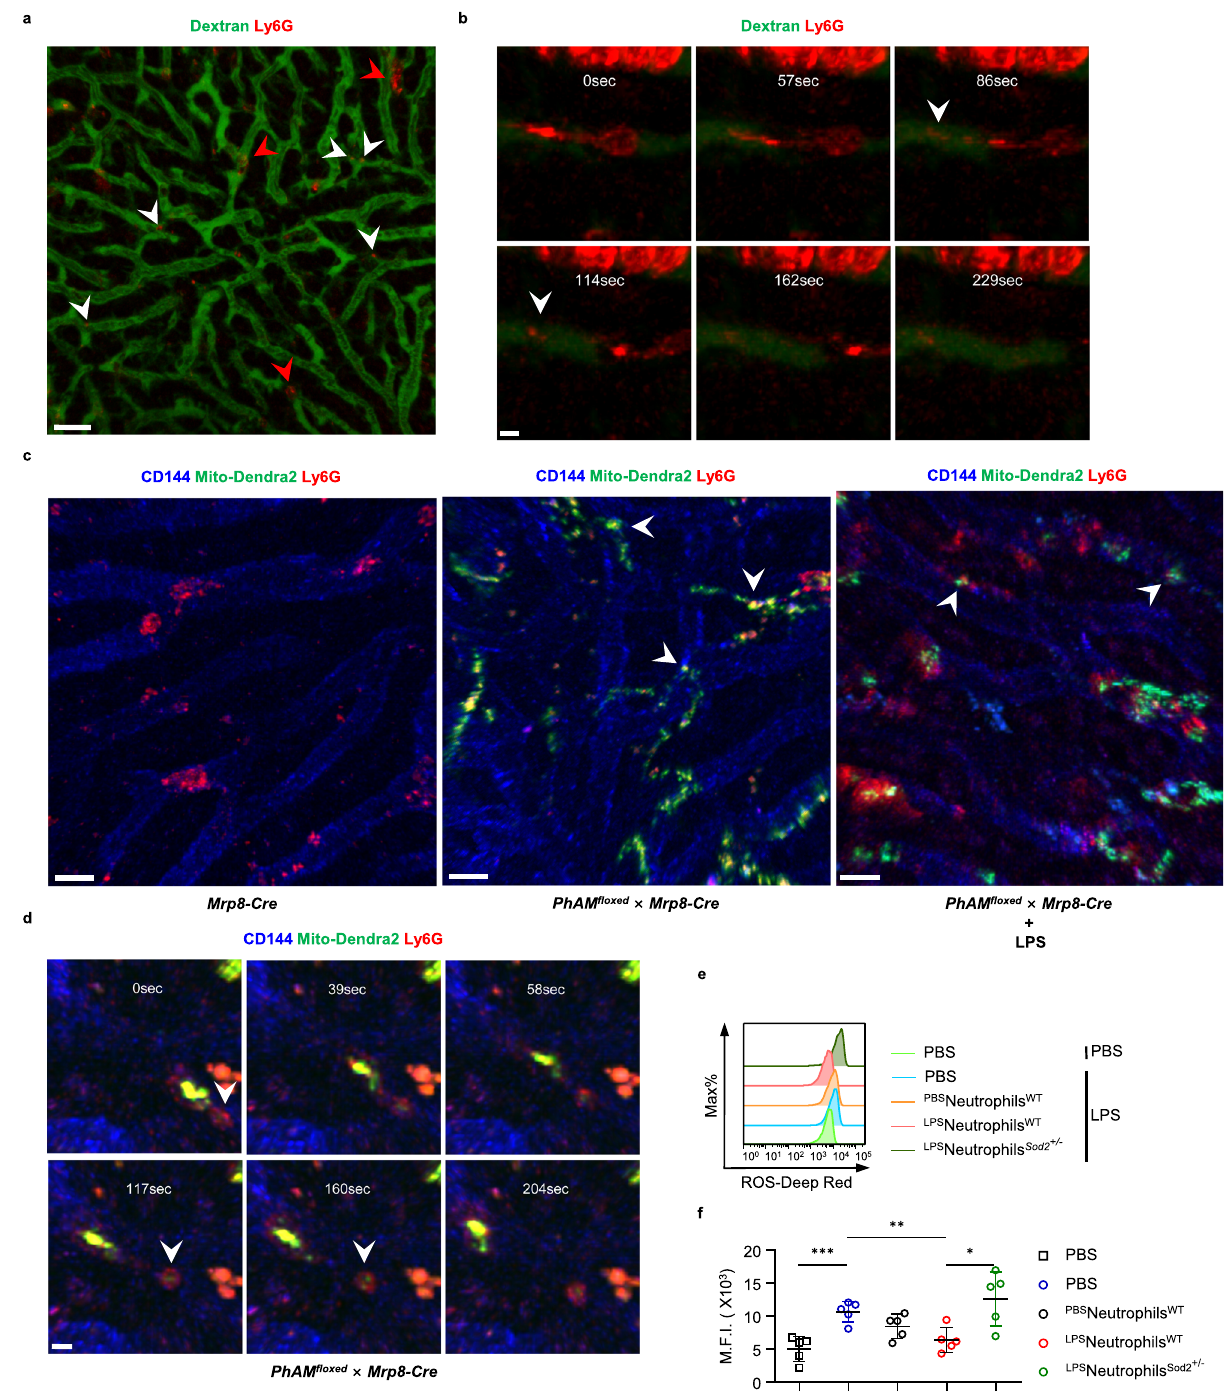
Fig. 5 | Neutrophils release mitochondrion-containing EVs during migration and reduce endothelial ROS accumulation. a – b Representative images from intravital imaging of neutrophils (Ly6G-Red, red arrows) within liver vasculature (Dextran-Green)inwildtypemice.Thewhitearrowindicatesavesiclereleasedbya migratingneutrophil.Scalebarin a ,30 μ m;Scalebarin b ,5 μ m. c – d Representative images from intravital imaging of neutrophils (Ly6G-Red) within liver vasculature (CD144-Blue) in PhAM fl oxed × Mrp8-Cre mice. Mitochondria of neutrophils were labeled by Mito-Dentra2 (Dendra2-Green). The white arrow indicates a